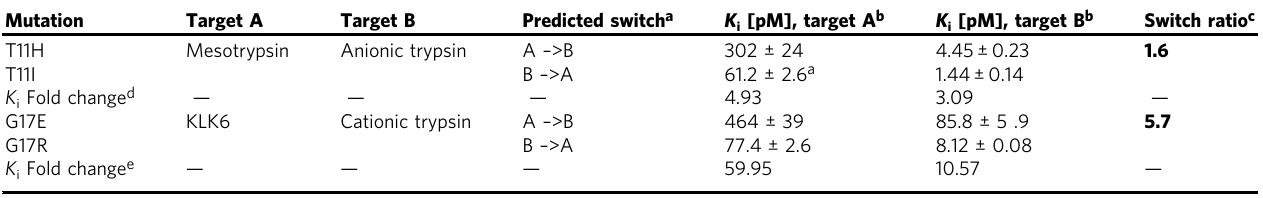
a As predicted by the NGS analysis b Results (means±SD) were obtained from three independent experiments c Calculated as the K i fold change for target A divided by the K i fold change for target